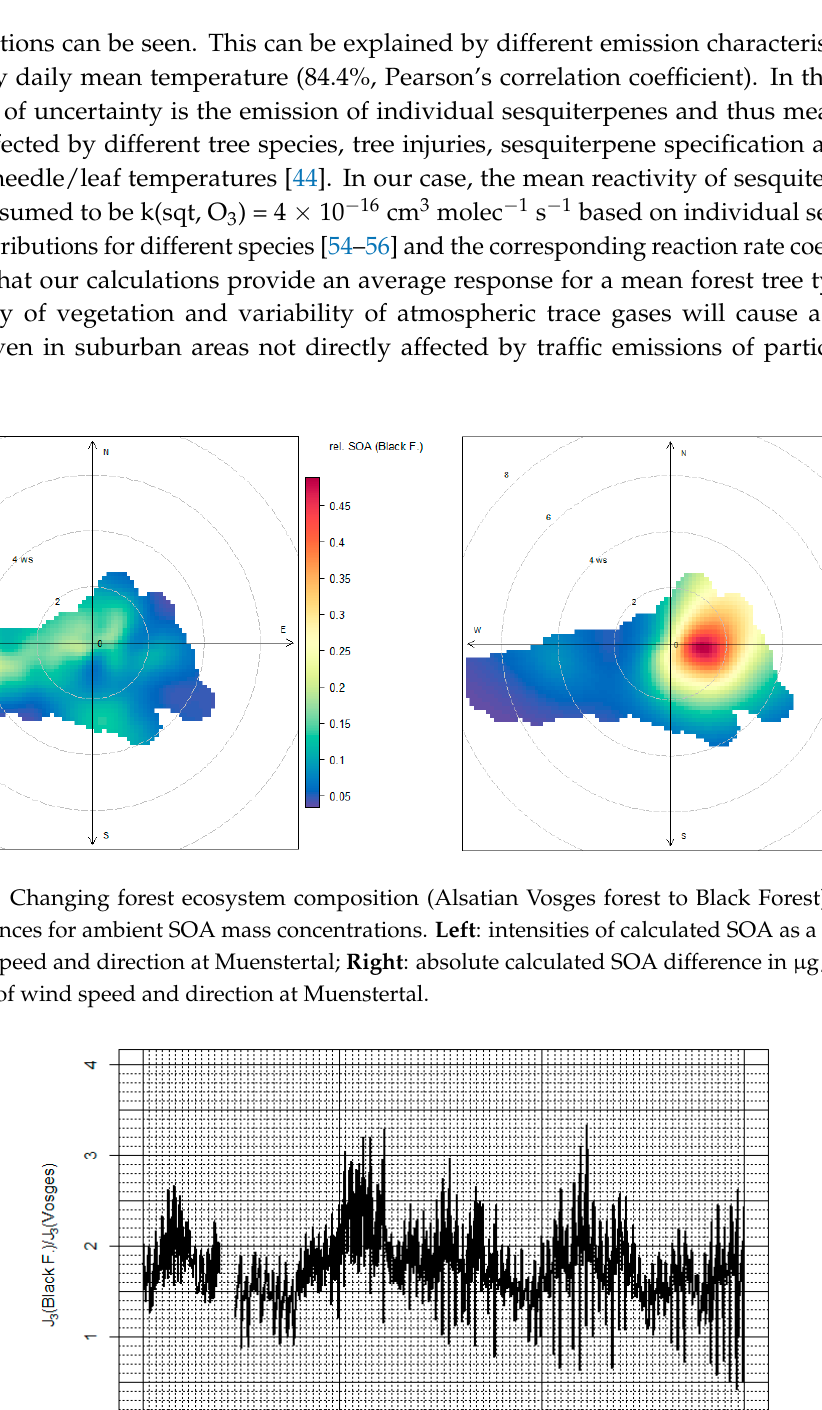
11 of 21 Figure 4. Summertime tropospheric (ground level) ozone mixing ratio: Observations in the Black Forest ( top ), effect of changing tree species contributions ( middle ) and of secondary organic aerosol ( bottom ). 3.3.2. Implications for Organic Aerosol Particles The total implications for ambient particulate matter concentrations tends to be minor and can change direction. If external SOA masses are advected and repartitioned to the gas-phase to a certain extent, they will intensify ozone production, while BVOCs emitted at the site of interest will either contribute to ozone formation or partition to the particle phase and will be therefore unable to join ozone production. The first effect is positive—e.g., for the Black Forest, a median of +31% is derived— and for the second effect a negative impact was calculated (e.g., the Black Forest median August 2015: − 14%) with different intensities throughout the day. Therefore, although the total SOA effect tends to be minor (Figure 5), opposing effects may be major and show up if the local situation is disturbed by local wind. With respect to the estimated total SOA mass concentration changes due to different emissions and oxidation between both forest types are about 0.5 µg/m 3 , which is less than 3% (Figure 5, on the left). The magnitude of the effect is related to different temperatures and the competition between higher emissions and organic aerosol mass precursor formation and the increased volatility of semi-volatile aerosol species.